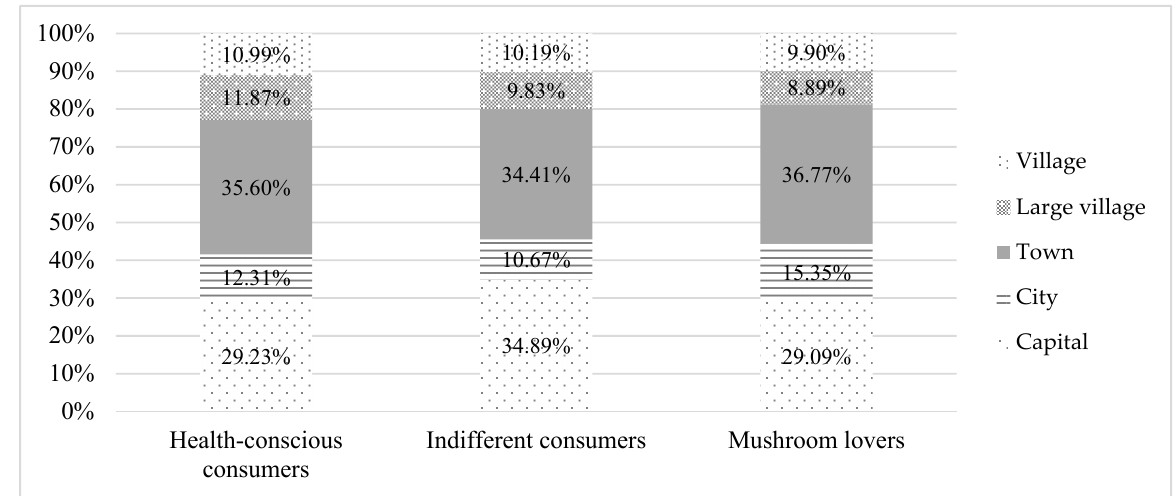
Figure 8. Distribution by location within clusters generated based on level of consciousness in mushroom consumption.